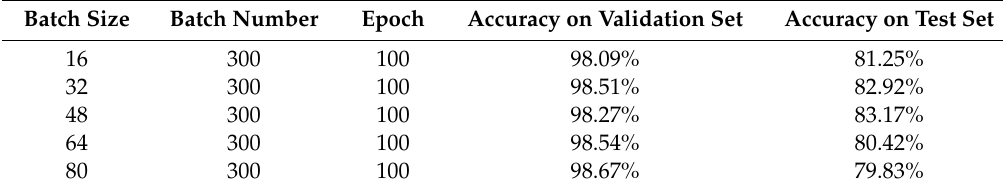
Table 5. Intrusion detection accuracy rate of di ff erent batch size.